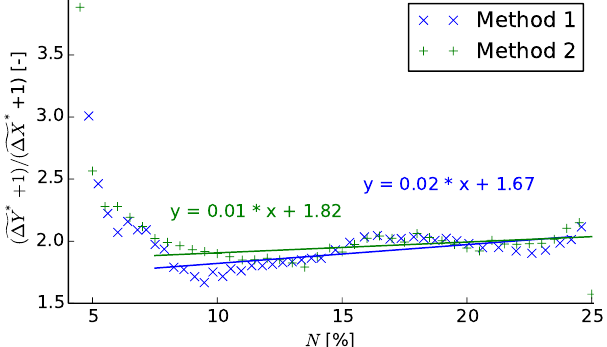
Figure 10. Optimal centre-to-centre aspect ratio as a function of the objective heat source